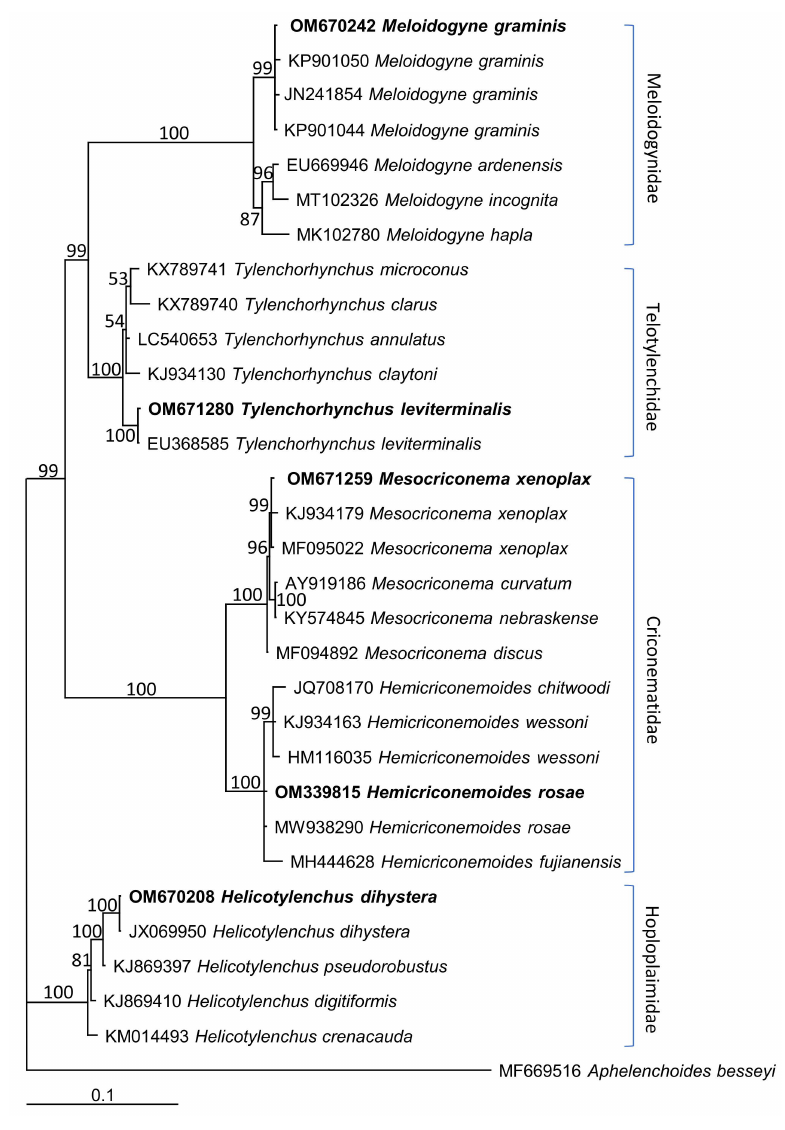
Figure 6. The 10,001st Bayesian tree inferred from 18S under the GTR + I + G model (lnL = 6925.1914; freqA = 0.2438; freqC = 0.2192; freqG = 0.2803; freqT = 0.2568; R(a) = 1.2950; R(b) = 2.2321; R(c) = 1.0279; R(d) = 0.7318; R(e) = 4.2831; R(f) = 1; Pinvar = 0.3455; Shape = 0.6090). Posterior probability values exceeding 50% are given on appropriate clades. The new species is in bold